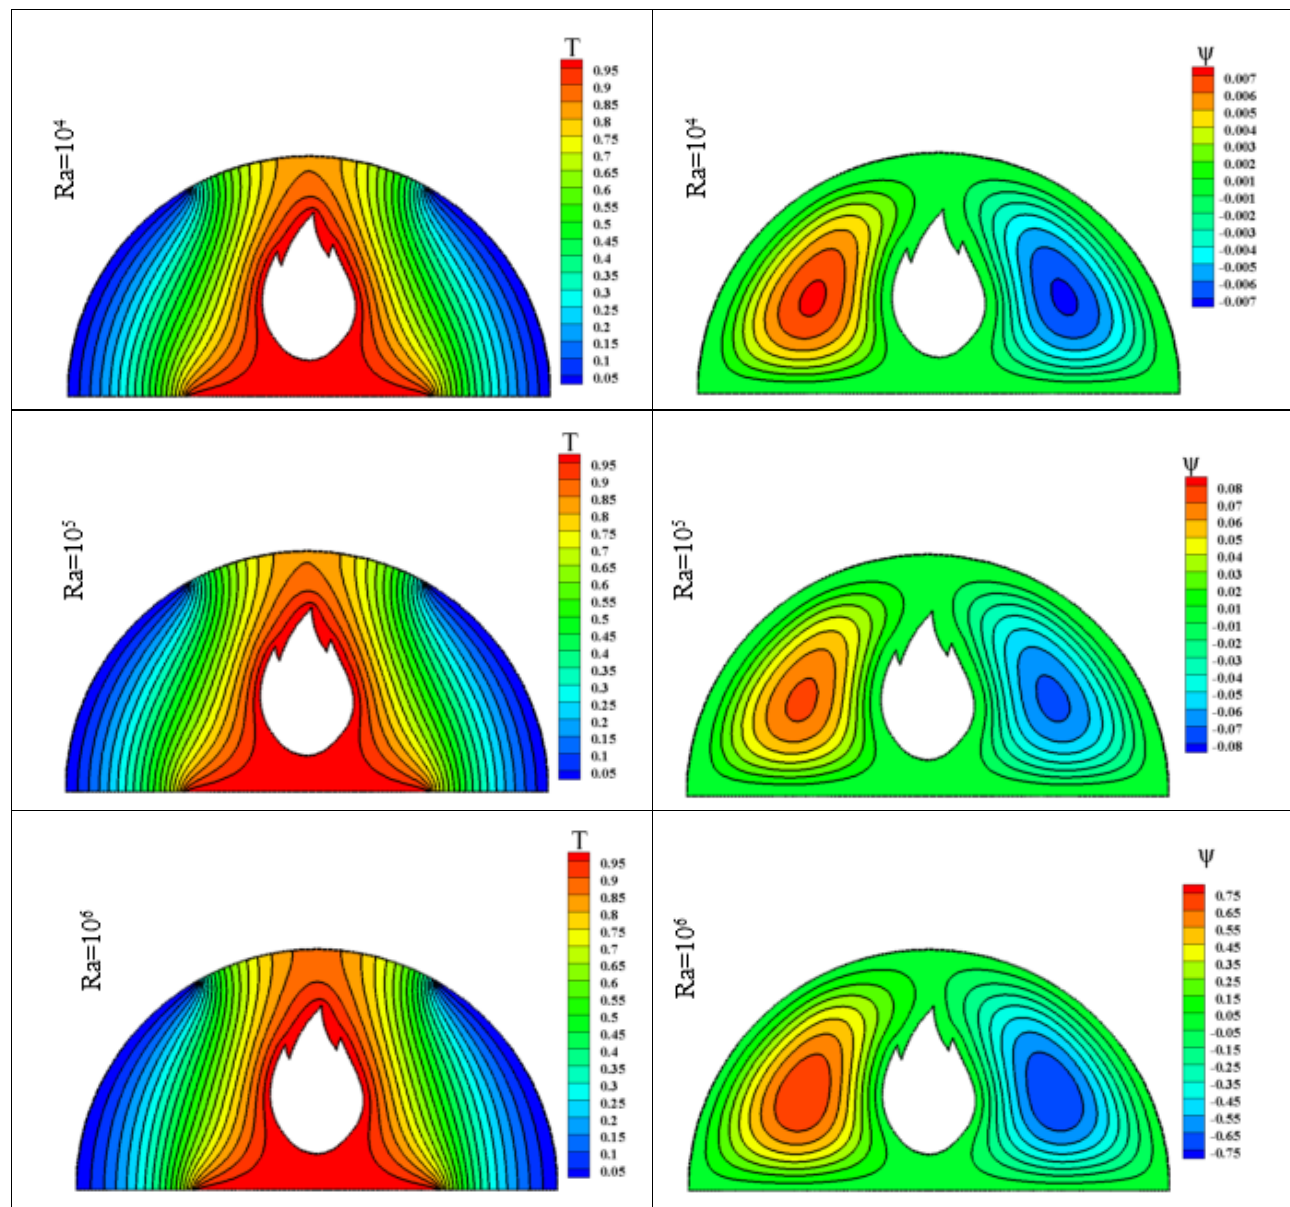
φ = 0.02, Ha = 50 and Rd = 0.5,